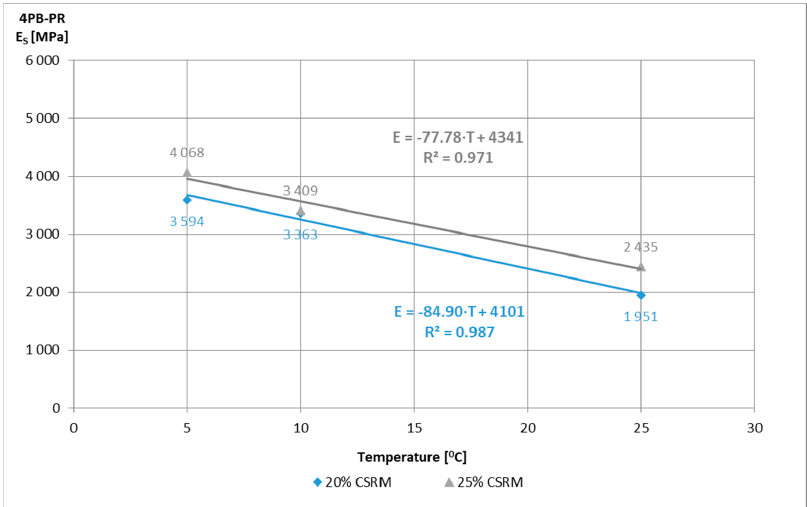
Figure 9. IT-CY stiffness modulus of ACCR with “B” CSR mortar samples Ø100 × 63.5 mm de- pending on the temperature, after 28 days of maturing.